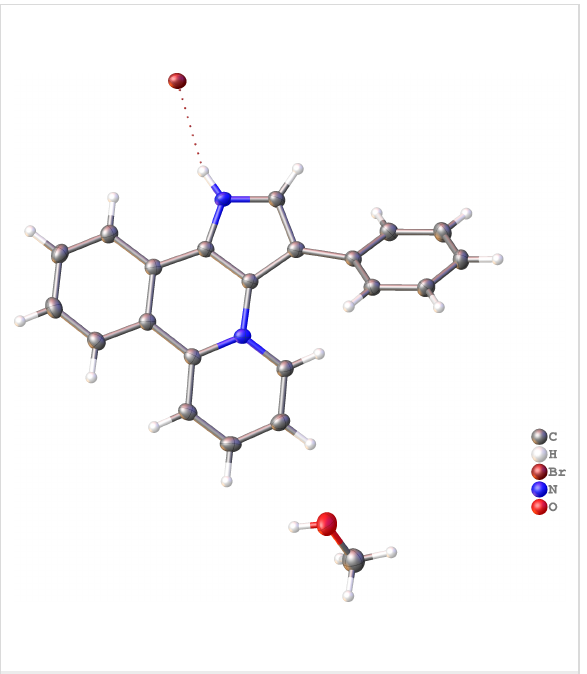
Figure 3: Molecular structure of compound 17a , displacement parame- ters are drawn at 50% probability